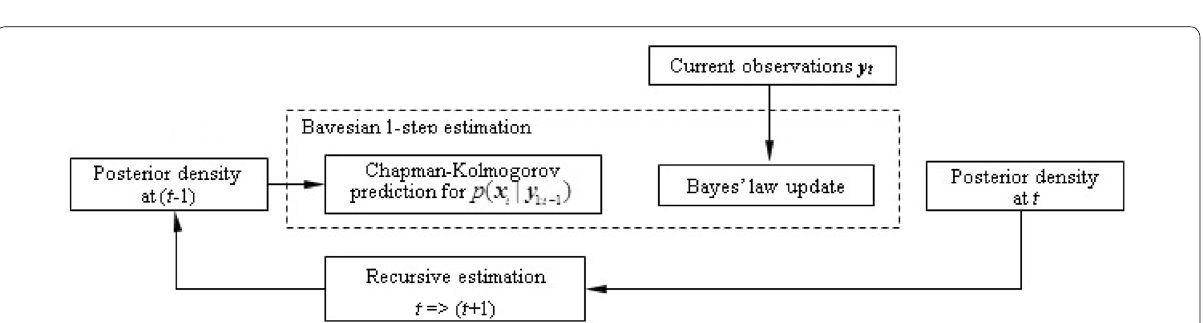
Figure 1 Procedure of Bayesian posterior density recursive